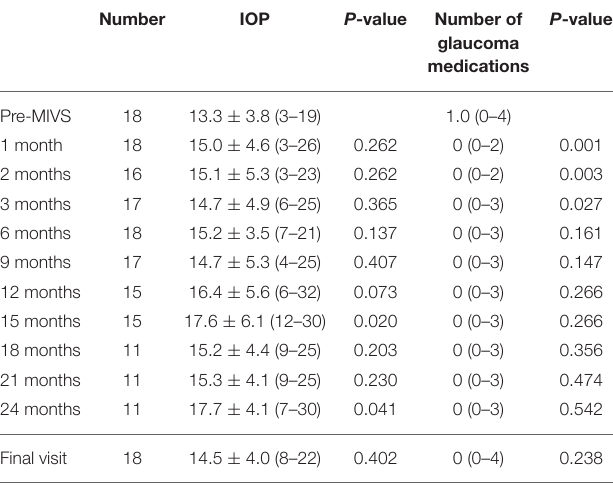
TABLE 1 | Changes in IOPs including additional intervention and the number of antiglaucoma medications.